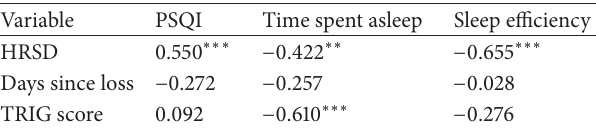
Table 2: Spearman rho correlation coefficients. Significance is denoted: ∗ 𝑃 < 0.05 , ∗∗ 𝑃 < 0.01 , ∗∗∗ 𝑃 < 0.001 (2-tailed). Sample